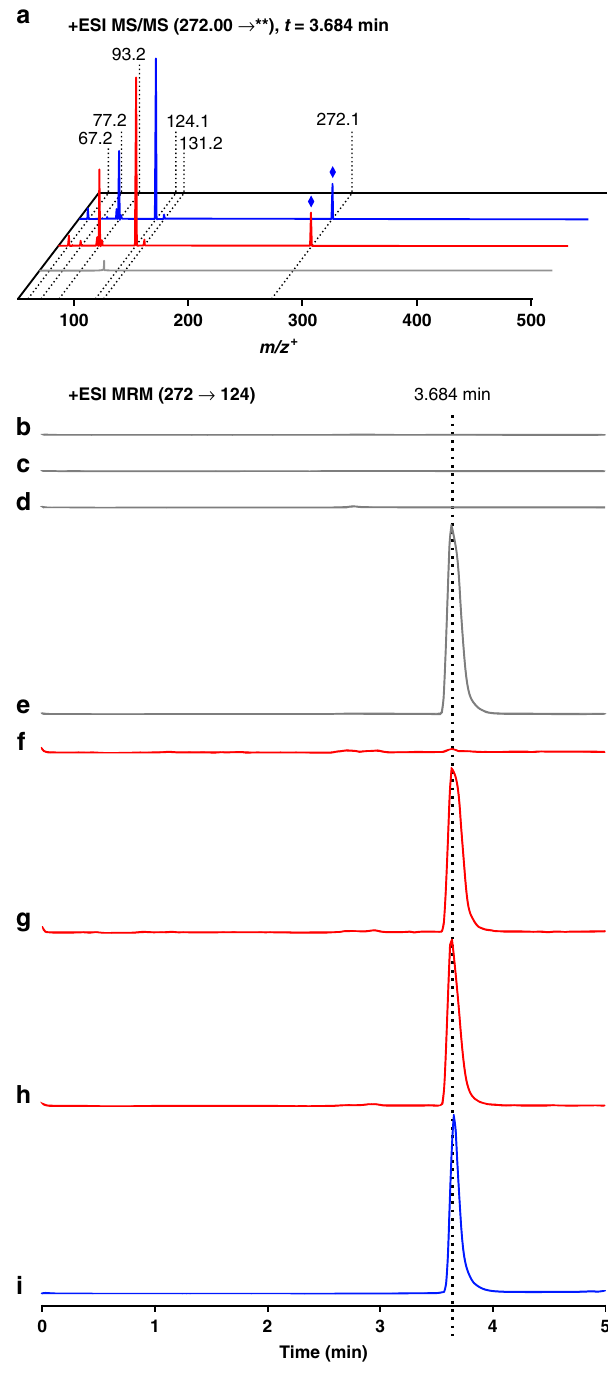
Fig. 5 De novo production of the non-canonical tropane alkaloid cinnamoyltropine in yeast. a Tandem MS/MS spectra of extracellular medium of CSY1251 (gray), CSY1282 (red), or a genuine cinnamoyltropine standard (blue) for a parent mass of m/z + = 272. Blue diamond indicates parent compound peak. b – i Validation of EcCS acyltransferase activity on cinnamic acid and α -tropine via substrate feeding. Strains were transformed with combinations of plasmids expressing AtPAL1 (low-copy plasmid pCS4252) and/or At4CL5 and EcCS (high-copy plasmid pCS4207), and then cultured in media with different supplemented substrates, as